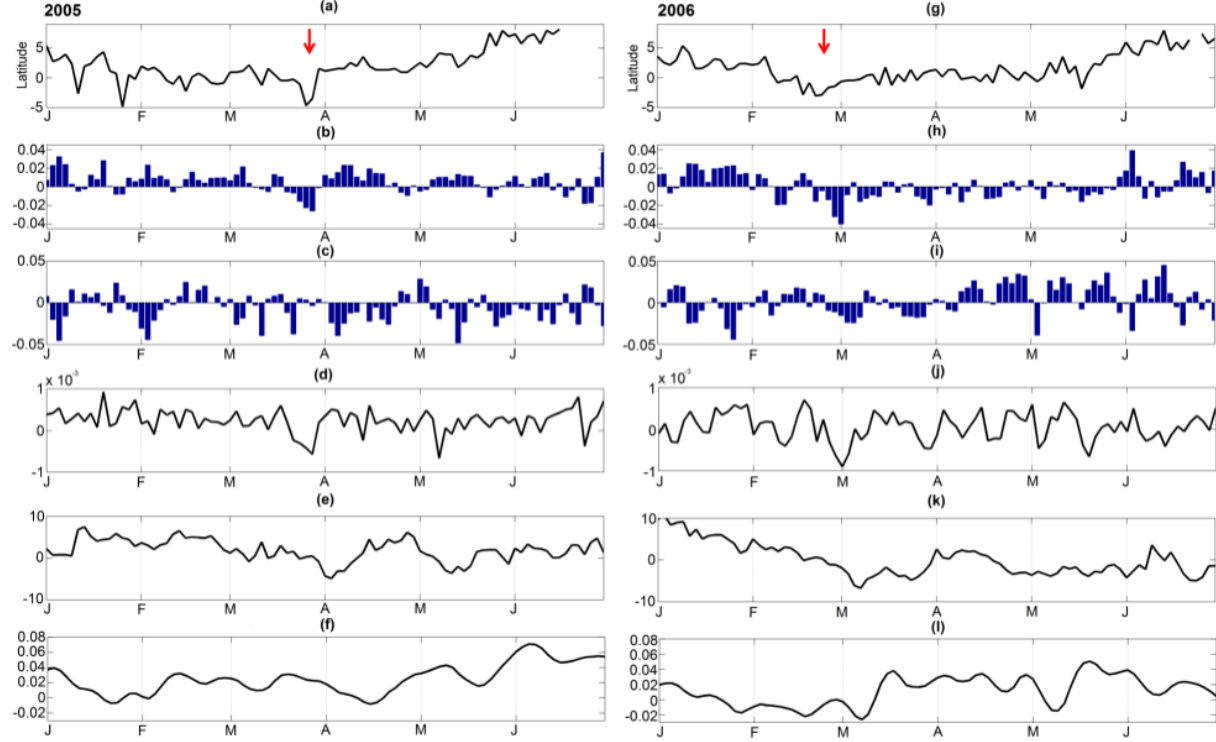
Figure 7. Time evolution from 2-day averaged model outputs over January–June 2005 (a–f) and January–June 2006 (g–l) of the following: (a, g) the position (in latitude, between 5 ◦ S and 10 ◦ N) where the meridional wind stress value equals zero (indicator of the position of the ITCZ); (b, h) the intraseasonal anomaly of the meridional wind stress (Nm − 2 ) averaged between 50 and 35 ◦ W and between 1 ◦ S and 1 ◦ N; (c, i) same as (b, h) but for intraseasonal anomaly of zonal wind stress (Nm − 2 ); (d, j) the intraseasonal anomaly of the wind stress curl (Nm − 2 ); (e, k) the intraseasonal anomaly of the 20 ◦ C isotherm depth (m; negative values indicate that the 20 ◦ C isotherm depth is closer to the surface); and (f, l) the intraseasonal anomaly of the sea level (m). The red arrow in (a, g) indicates the southward shift of the ITCZ before the generation of the Kelvin wave (see text). For details about the calculations of anomalies, see Sect. 2.